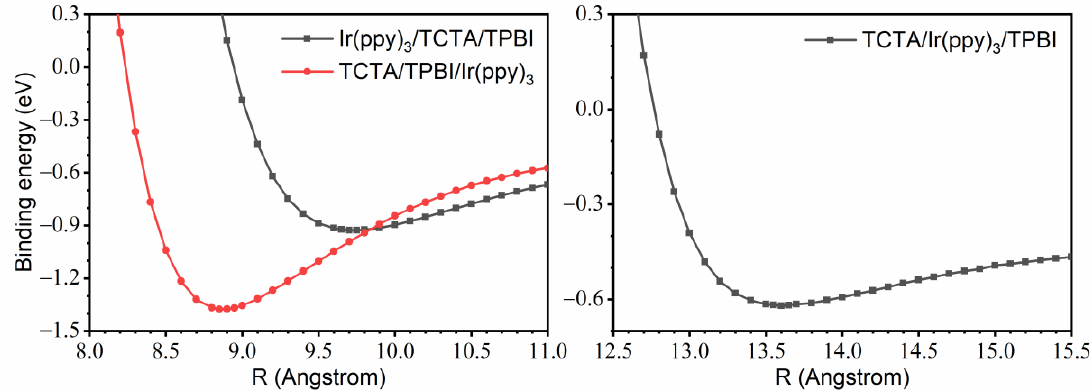
Figure 5. One-dimensional ground state potential energy surfaces of the trimer model systems as functions of the center-to-center distance between Ir(ppy) 3 and the TCTA/TPBI complex.